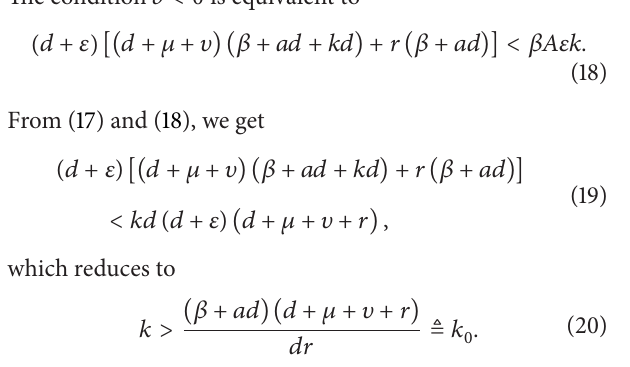
Figure 1: The figure of infective sizes at equilibria versus 𝑅 0 when 𝛽 = 0.05 , 𝜀 = 1.2 , 𝑑 = 0.2 , 𝜇 = 0.2 , 𝜐 = 0.4 , 𝑟 = 1.5 , 𝛼 = 0.1 , and 𝑘 = 2 , where 𝑘 is big enough to lead a backward bifurcation with two endemic equilibria when 𝑅 𝑐 0 < 𝑅 0 < 1